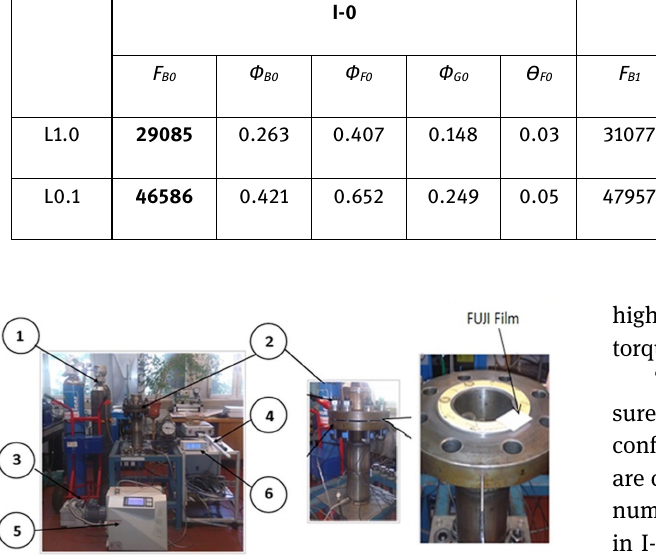
Figure 18: Test rig to investigate flange-bolted joint with gasket 1 –helium reservoir, 2 – flange-bolted joint, 3 – vacuum pump, 4 – torque wrench, 5 – helium detector, 6 –